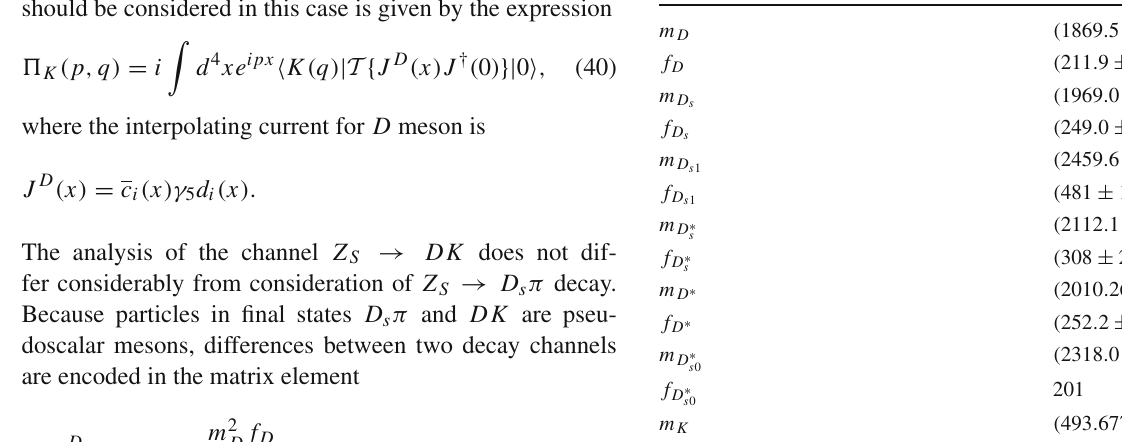
Table 2 Parameters of the mesons used in numerical calculations